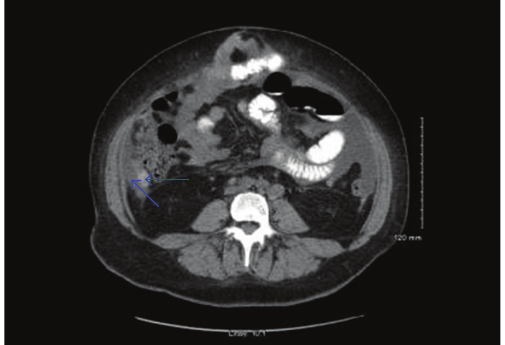
Figure 1: CT Abdomen without IV contrast, revealing calcified, heterogeneous, mixed intermediate, and high-density deposits worrisome for peritoneal carcinomatosis.